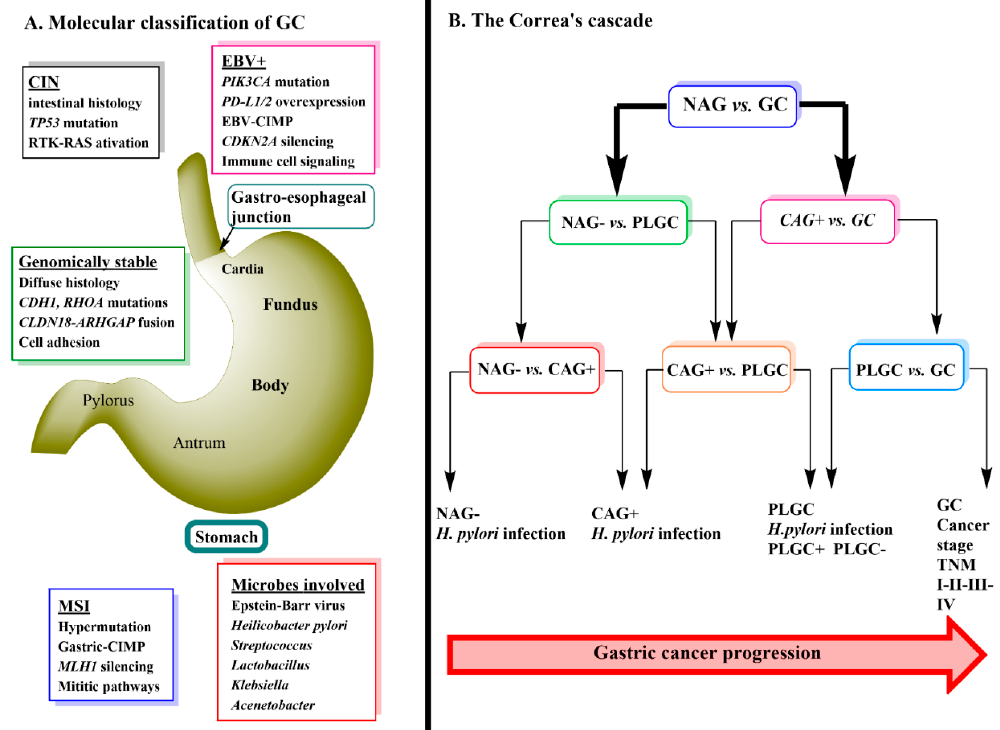
Figure 1. ( A ) Molecular classification of gastric cancer . Four tumor subgroups have been identified: positive for Epstein- Barr virus (EBV, 9%), microsatellite unstable (MSI, 22%), genomically stable (20%) and chromosomally unstable tumors (CIN, 50%). Genomically stable tumors are ~73% correlated histologically with diffuse tumors. CIN tumors are mainly gastro-esophageal junction adenocarcinomas (intestinal type tumor) and EBV tumors are found predominantly in either the fundus or body of the stomach with 81% of these found in males. Women have more MSI tumors (56%, intestinal, antrum location) [12]. CIN is characterized by DNA aneuploidy, translocation of chromosomes and mutations in proto-oncogenes and tumor suppresser genes [13] while MSI tumors are characterized by DNA mismatch repair defects caused by epigenetic events such as hypermethylation [14]. ( B ) Correa’s cascade. The progression of GC occurs via multiple precancerous lesions and is often described by Correa’s cascade. The stepwise progression starts with superficial non-atrophic gastritis (NAG) which can then advance to precursor lesions of GC (PCGL) which proceeds through multifocal atrophic gastritis, intestinal metaplasia and dysplasia before it ultimately becomes GC. H. pylori infection occurs at all stages in the cascade. Abbreviations: cadherin-1 (CDH1), claudin18 (CLDN18), CpG island methylator phenotype (CIMP), cyclin-dependent kinase inhibitor 2A (CDKN2A, tumor suppressor), MUTL homolog 1 (MLH1, tumor suppressor), programmed death ligand 1/2 (PD-L1/2, proto-oncogene), Phosphatidylinositol-4,5-Bisphosphate 3-Kinase Catalytic Subunit Alpha (PI3KCA, proto-oncogene), ras homolog gene family member A (RHOA, proto-oncogene), rat sarcoma virus (RAS, proto-oncogene), receptor tyrosine kinase (RTK), Rho GTPase activating protein (ARHGAP), tumor protein 54 (TP53, tumor suppressor) Reference for microbiota involvement